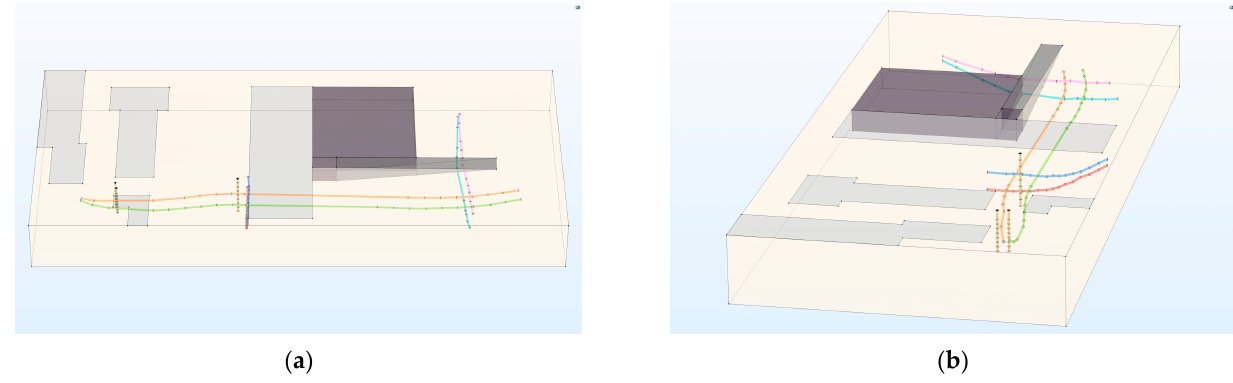
Figure 3. Lengthwise ( a ) and diagonal ( b ) perspectives of the experimental boreholes. Two parallel horizontal boreholes (BOHR1 and BOHR2) were drilled with a length of 126 m. Additionally, 4 horizontal-orthogonal (BOHR3–BOHR6) and 3 vertical-orthogonal (KERN1–KERN3) boreholes were drilled around the heated borehole (BOHR2) for temperature measurement with an additional 4 vertical boreholes for soil sampling. Figure 4 below shows an aerial perspective of the 126 m-long boreholes and the additional boreholes used for recording temperature overlaid on the property layout. Each borehole and sensor ID are labeled with a color-coded name corresponding to the borehole (e.g., BOHR3, 210, V1_20), and sensors are indicated with a small yellow-and-magenta diamond (